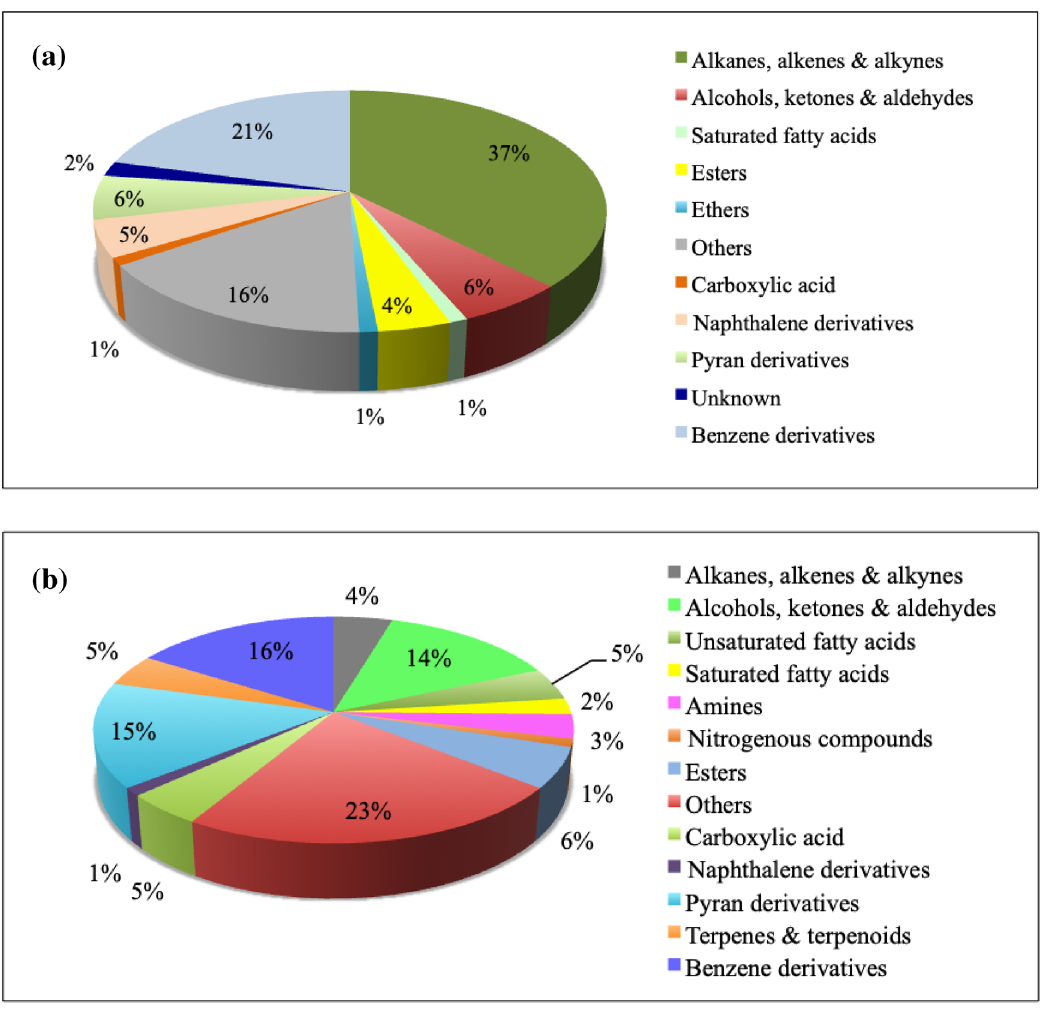
Figure 6. Percentage distribution of organic compounds in culture filtrates of ( a ) Bacillus subtilis , and ( b ) Trichoderma harzianum , identified by GC–MS in ethyl acetate